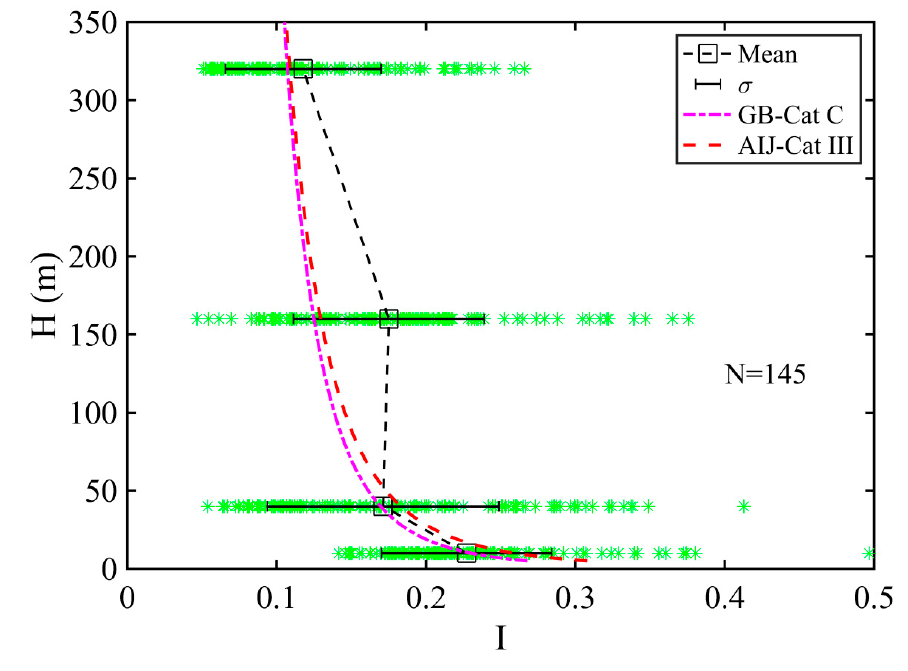
Figure 5. Ensemble mean turbulence intensity profile of all 6 events.